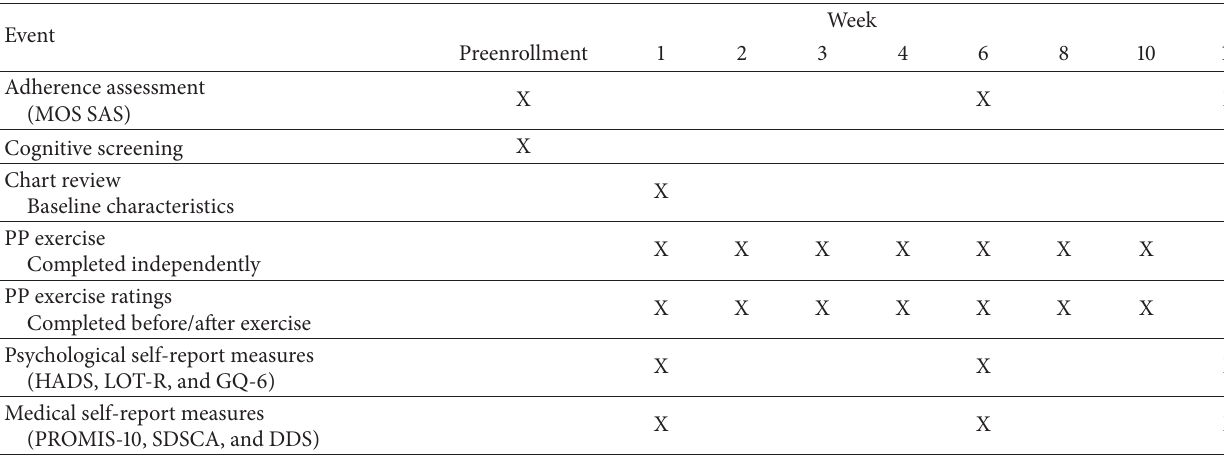
Table 1: Schedule of study